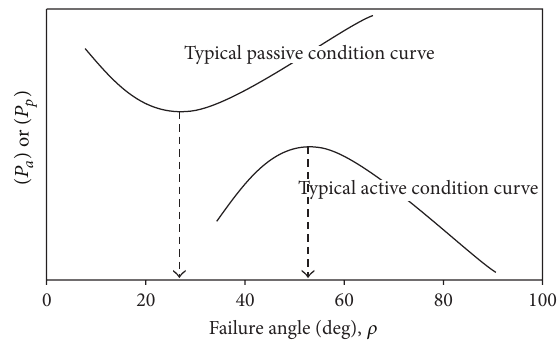
Figure 8: Typical active and passive condition